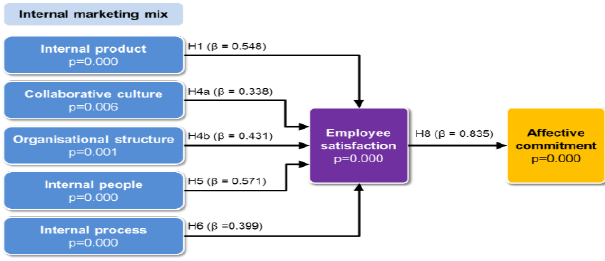
Figure 2: The final refined theoretical model proposed based on the overall regression